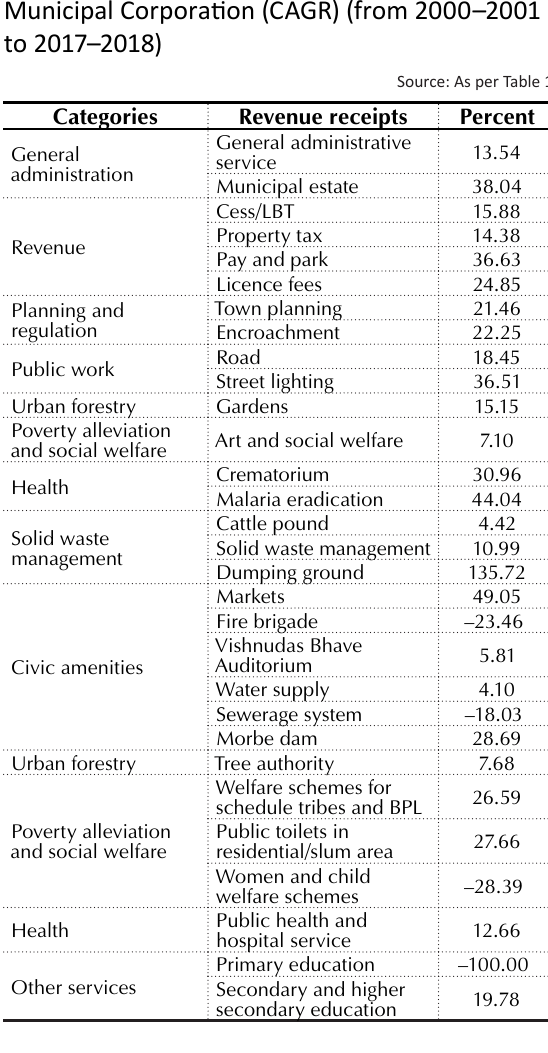
Figure 2. Revenue and capital receipts, grants and tax of Table 2. The revenue receipts of Navi Mumbai